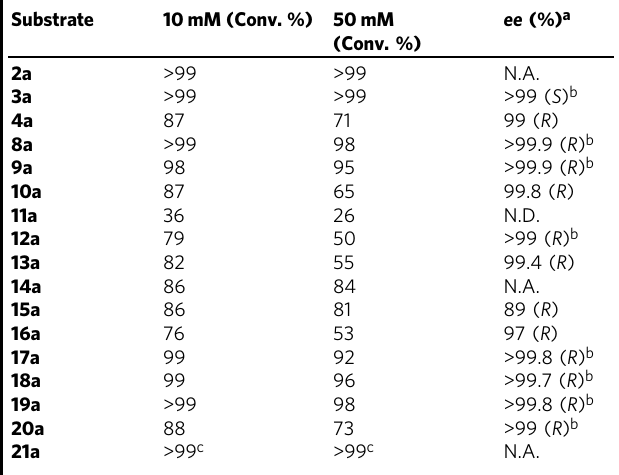
Table 1 Reductive amination of a panel of ketones and aldehydes employing LE-AmDH-v1